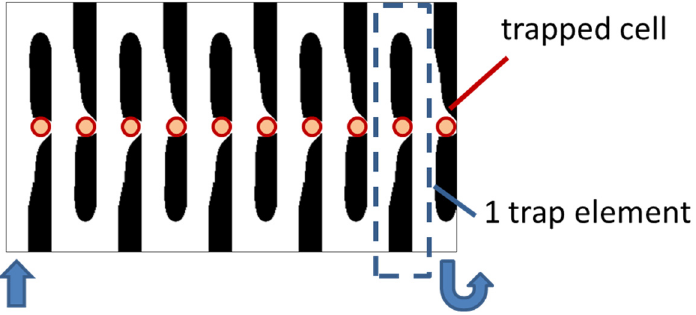
Figure 8. Cell capture array with capture direction perpendicular to flow direction (1 × 10).